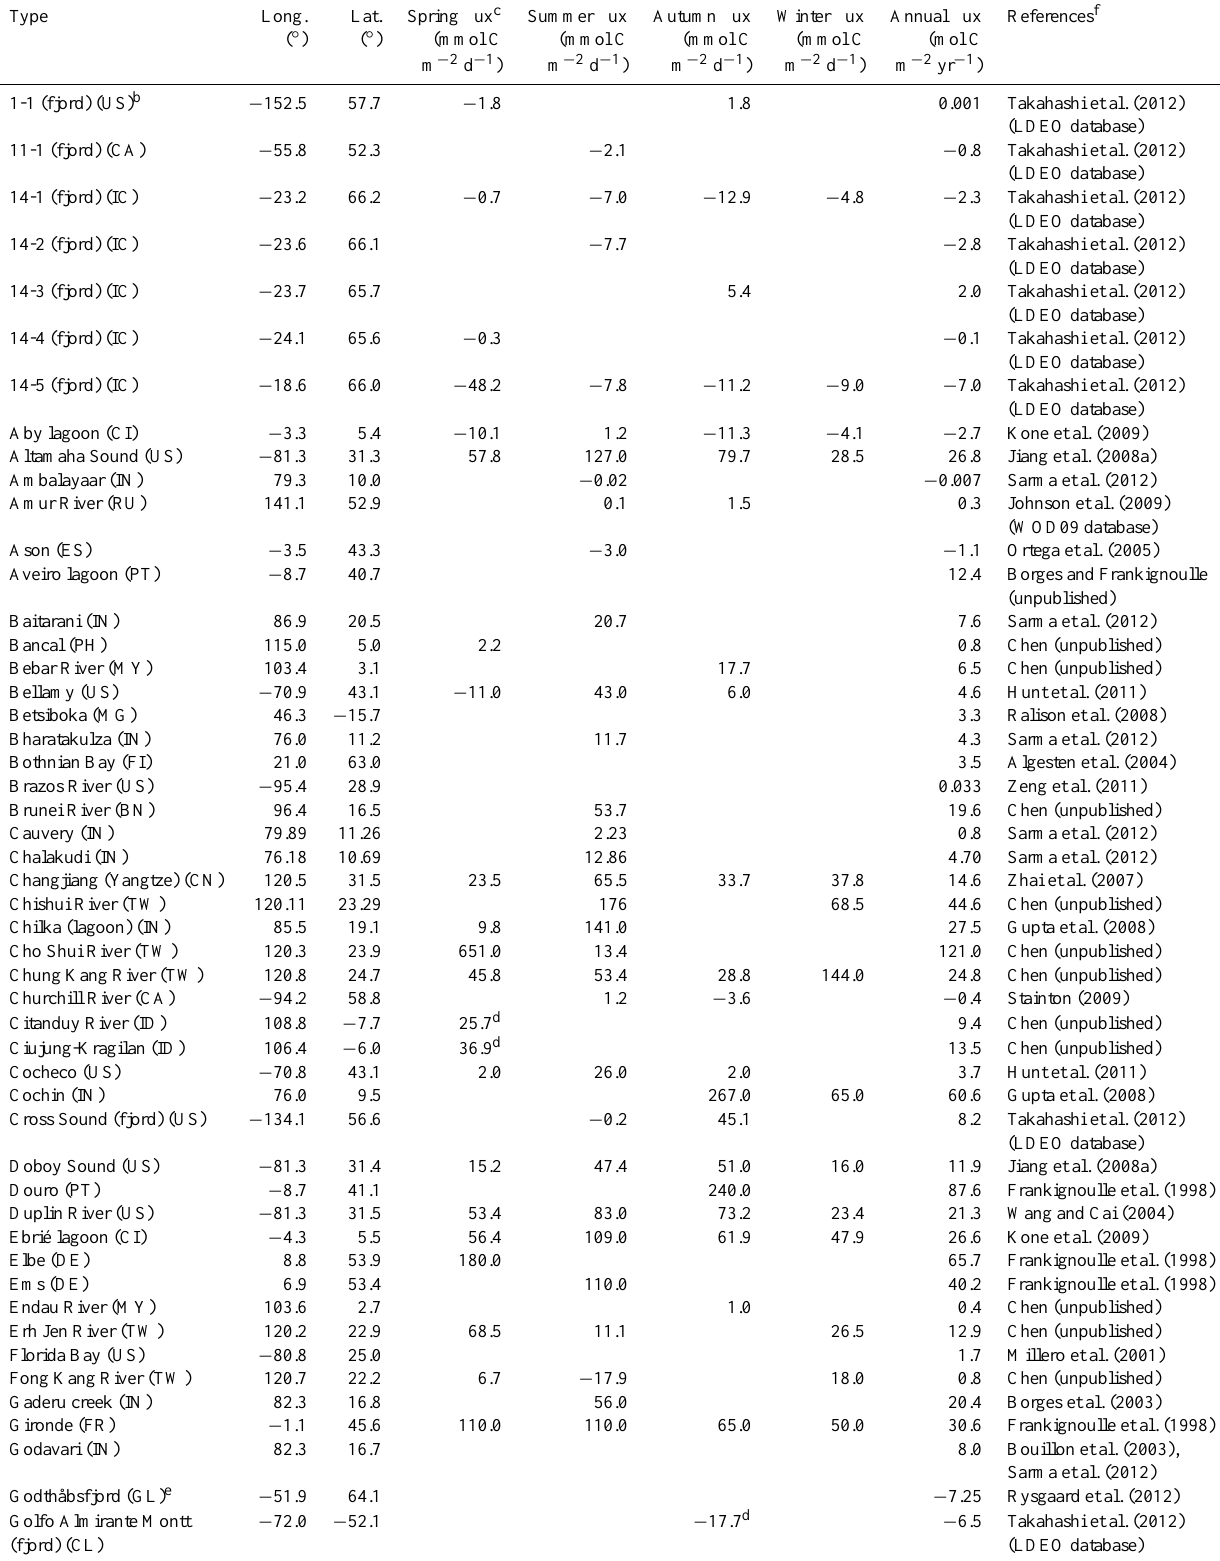
Table 1. Seasonal and annual sea-to-air fluxes of CO 2 in the world’s estuaries.